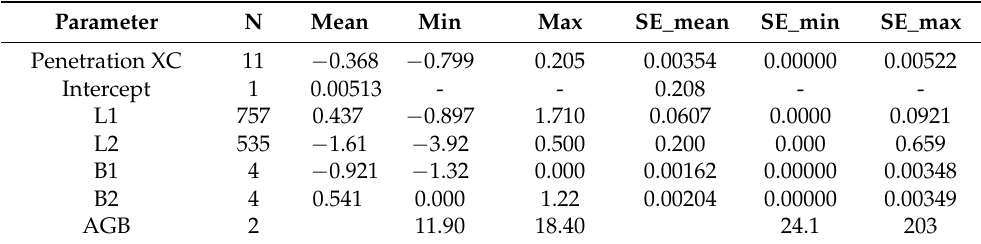
Table 4. The 7 input parameters for the Monte Carlo simulation, with the number of parameter values (N), their mean and min-max and the mean and min-max of their standard errors. Parameter N Mean